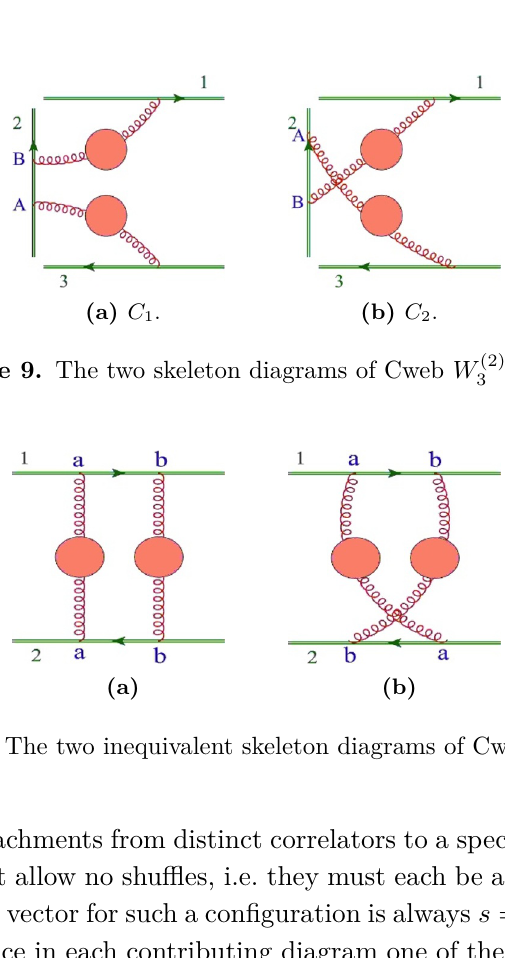
Figure 10. The two inequivalent skeleton diagrams of Cweb W (2)